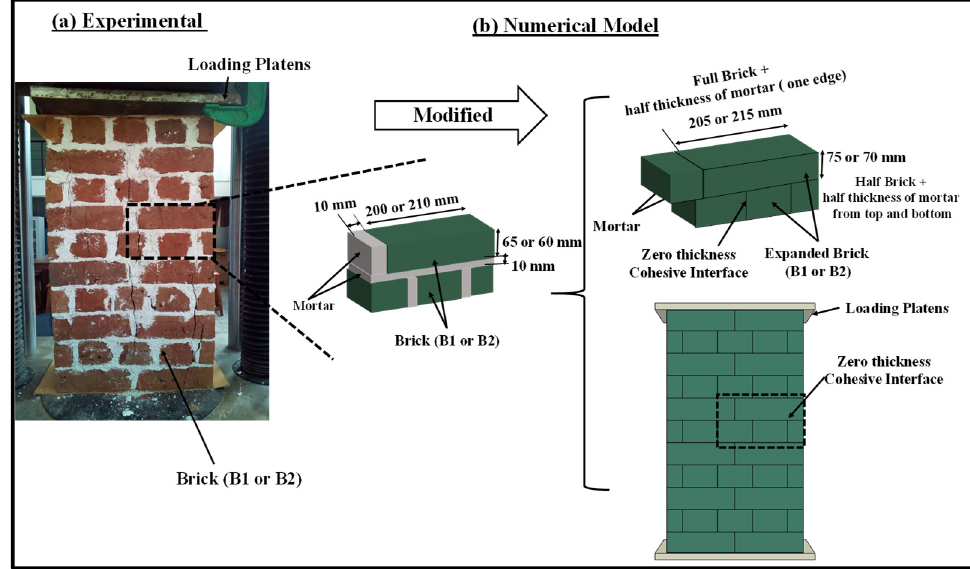
Figure 1. Numerical modelling of double-brick thick wallettes using expanded size of brick units and zero-thickness